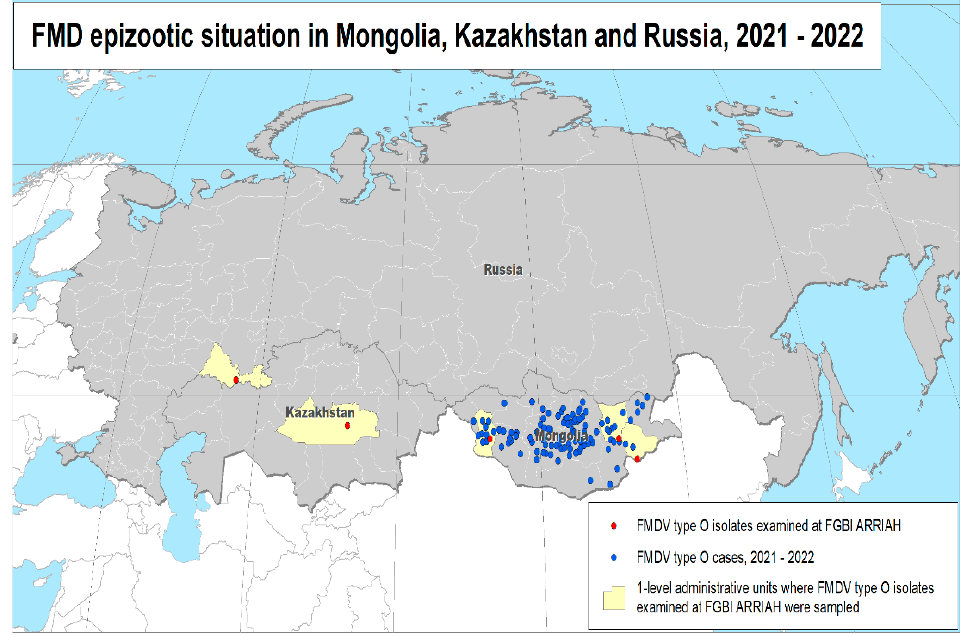
Figure 2. Map showing foot-and-mouth disease outbreaks in 2021 and 2022 in the subregion. The territory of the village of Karagach, Belyaevsky district, Orenburg region was previously included in the free zone without FMD vaccination without official recognition by the OIE. After studying the clinical lesions of the oral mucosa in the cattle, the probable timing of the animal disease was provisionally determined, namely, the period from 10 to 22 December